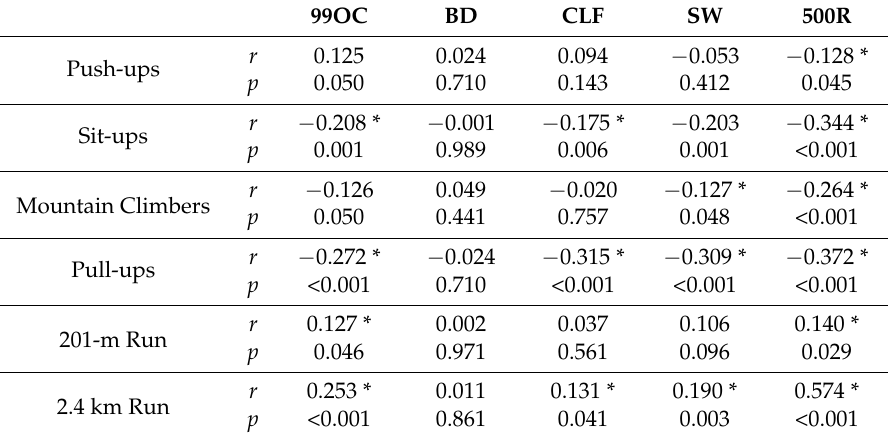
Table 2. Relationships between the PT500 and WSTB in law enforcement recruits ( n = 253).